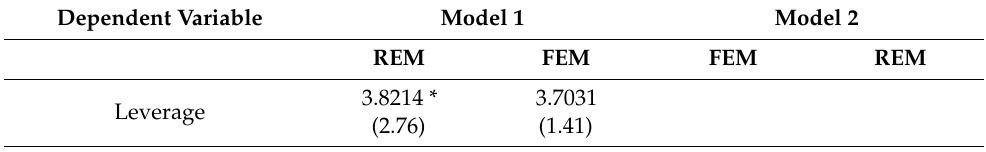
Table 7. Panel regression output for Return on Equity